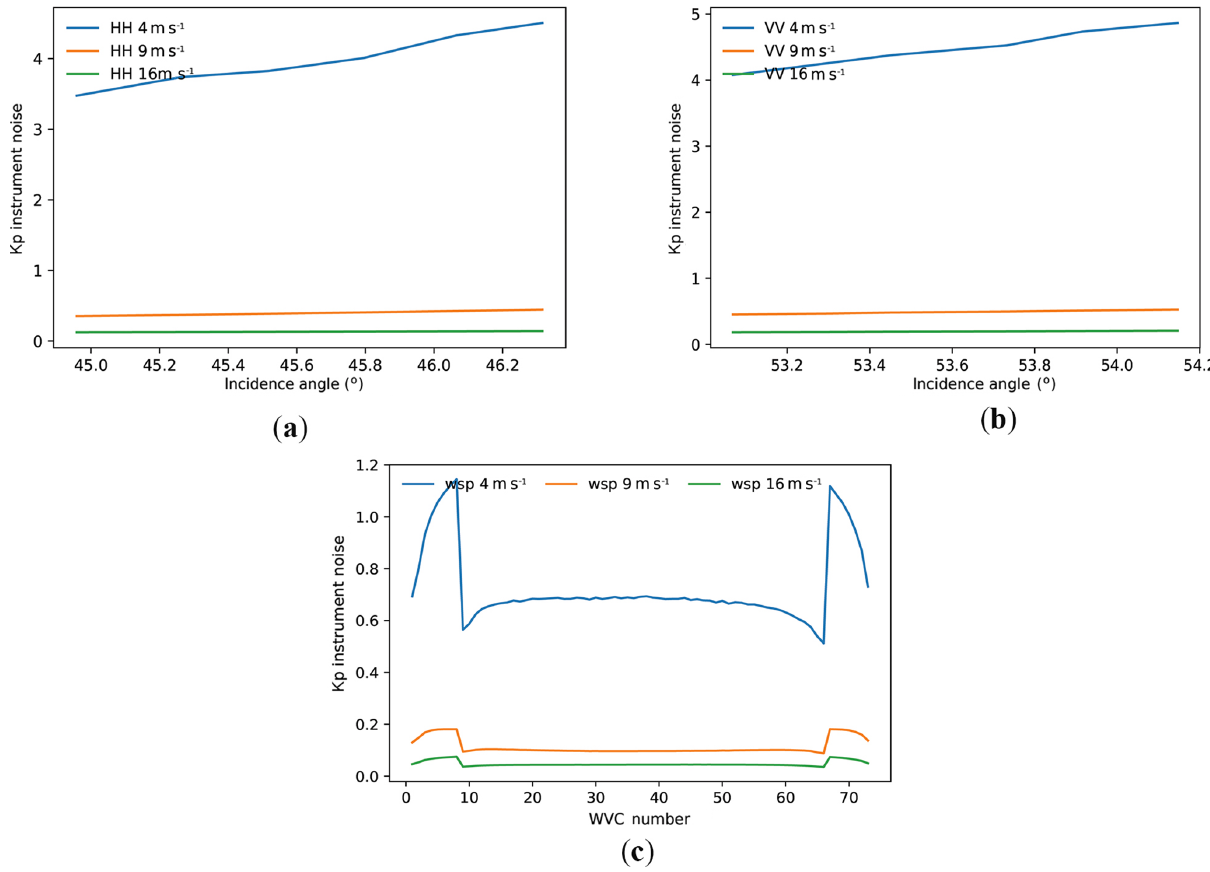
Figure 13. SeaWinds instrument noise in ratio (1 is 100%) at 4, 9, and 16ms − 1 on (a) slice level of Ku-band HH polarization, (b) slice level of Ku-band VV polarization (slices with SNR < 0 . 05 are excluded), and (c) WVC mean Kp.